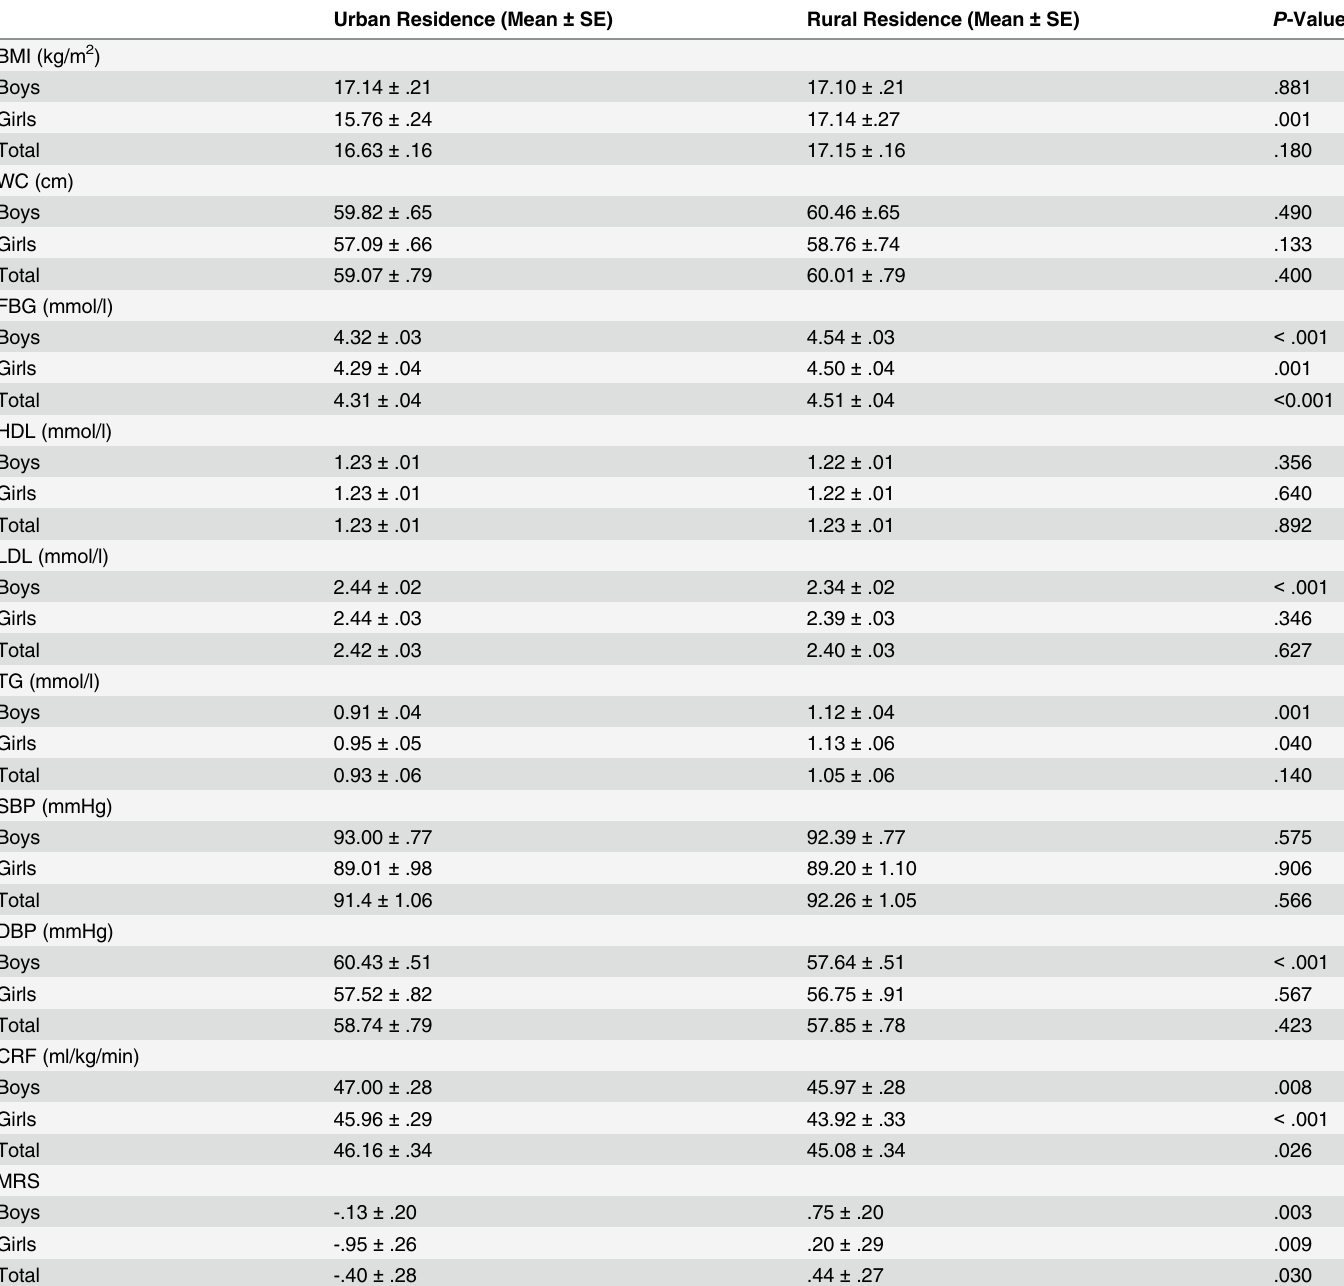
Table 2. Participants ’ CVD risk factors among different residence a